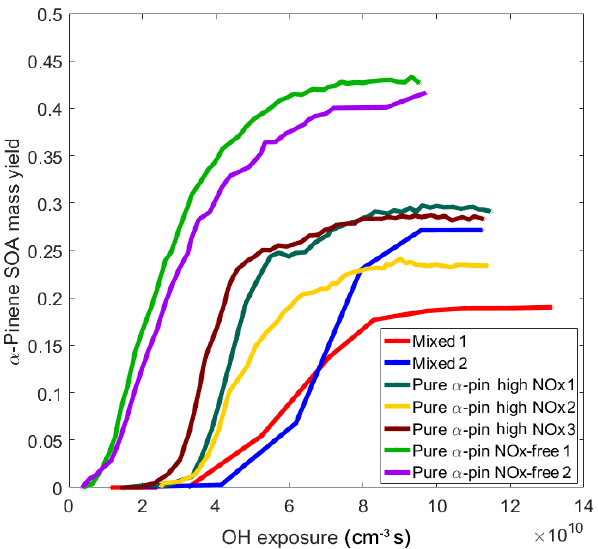
Figure 6. α -Pinene SOA mass yield as a function of OH expo- sure from all experiments. To calculate α -pinene SOA mass yield for Mixed experiments, an assumption was made that ASOA con- tributed the same fraction from total SOA throughout the experi-